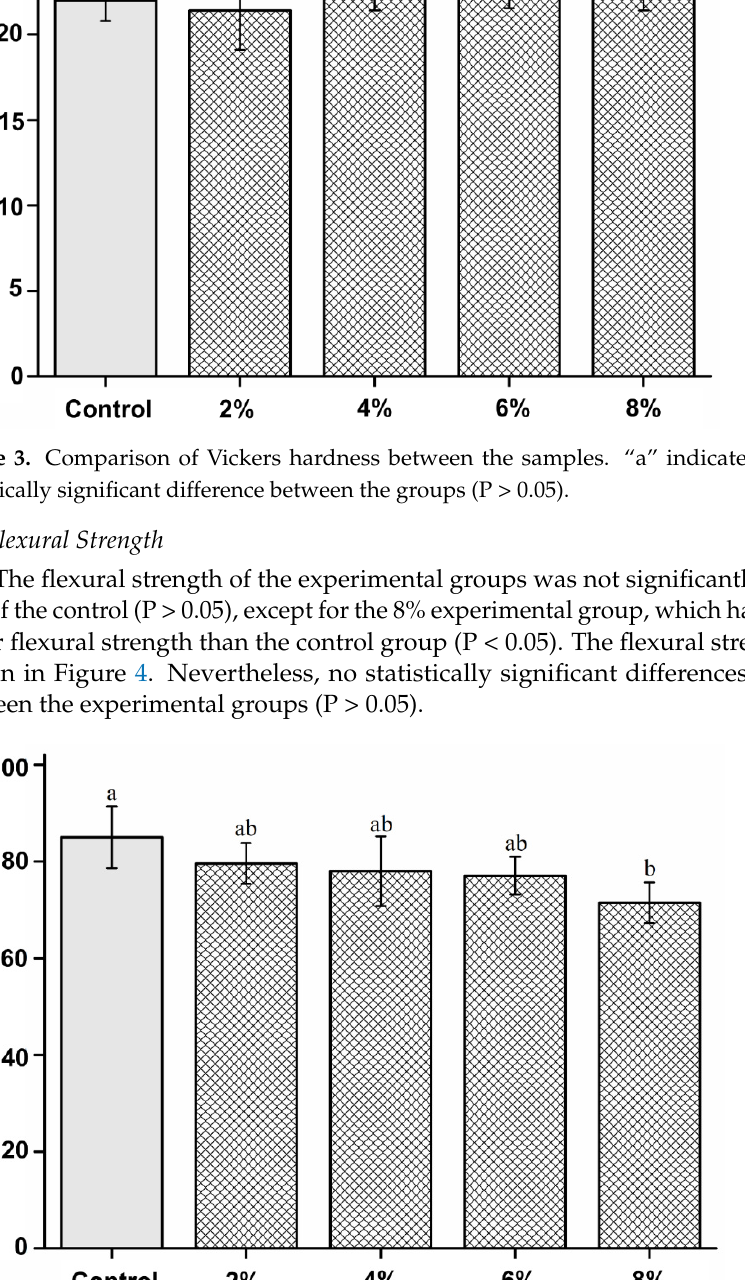
Figure 2. Representative SEM micrographs of the sample surfaces: ( A ) control, ( B ) 2%, ( C ) 4%, ( D ) 6%, ( E ) 8%.